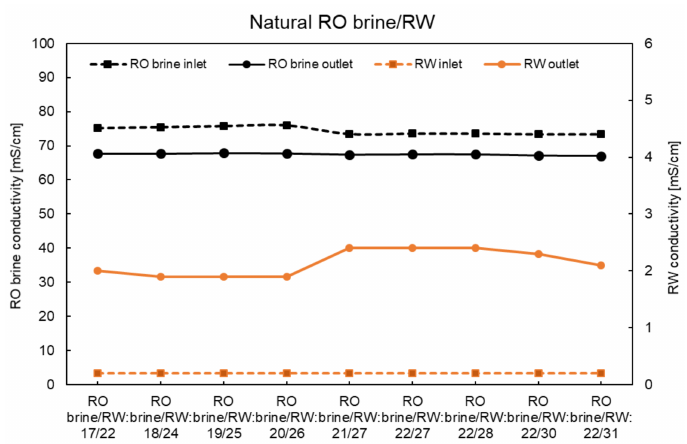
Figure A1. Conductivity of inlet and outlet solutions using the natural RO brine/RW at zero current.